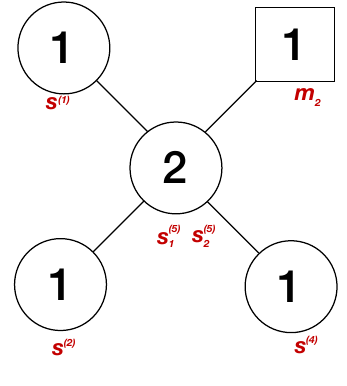
Figure 7 . b D 4 quiver with